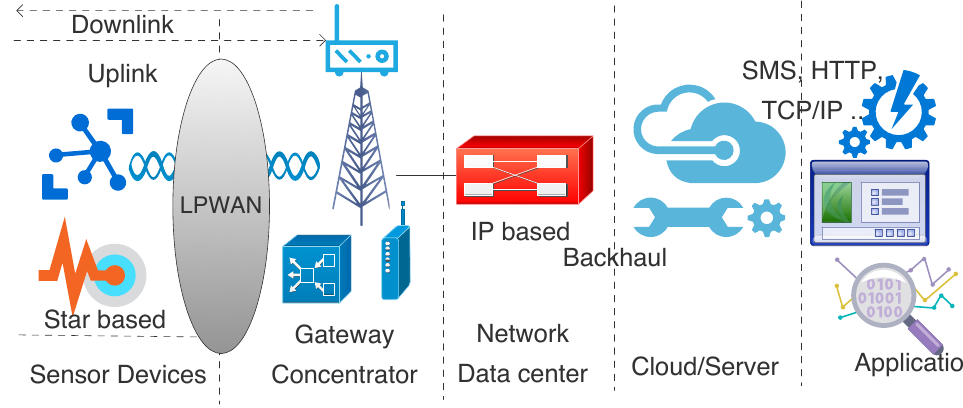
Figure 2. LPWAN common architecture featuring key elements and